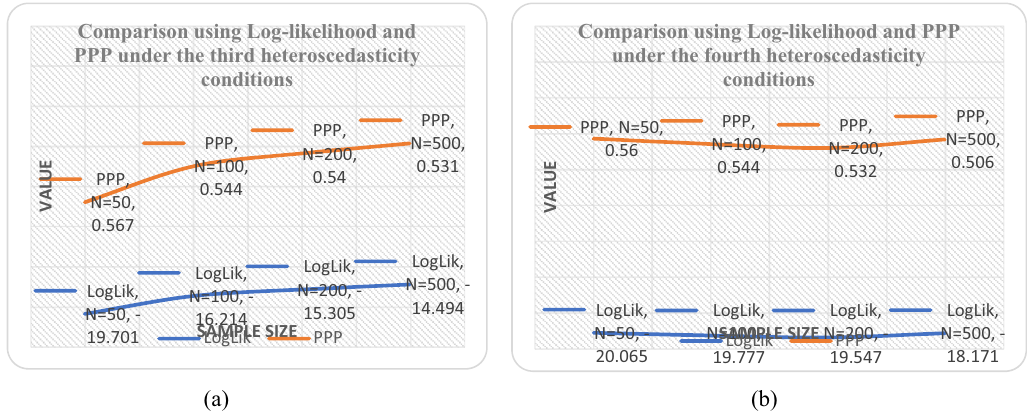
Figure 2.Plotofloglikelihoodand posterior predictivedistribution (PPP)at varioussamplesizes under(a)the linear-inverse form (b) the linear-absolute form.